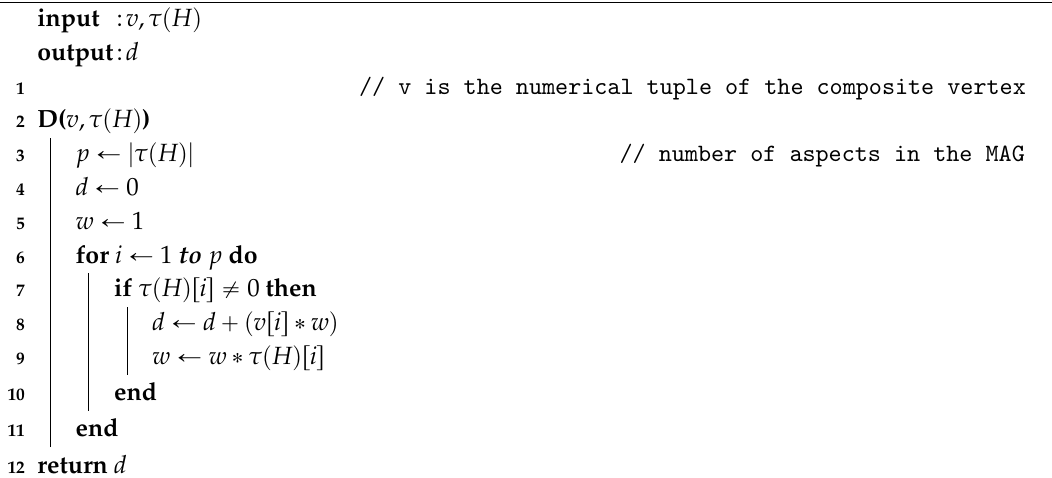
Algorithm 3: Determination of the numerical representation of a composite